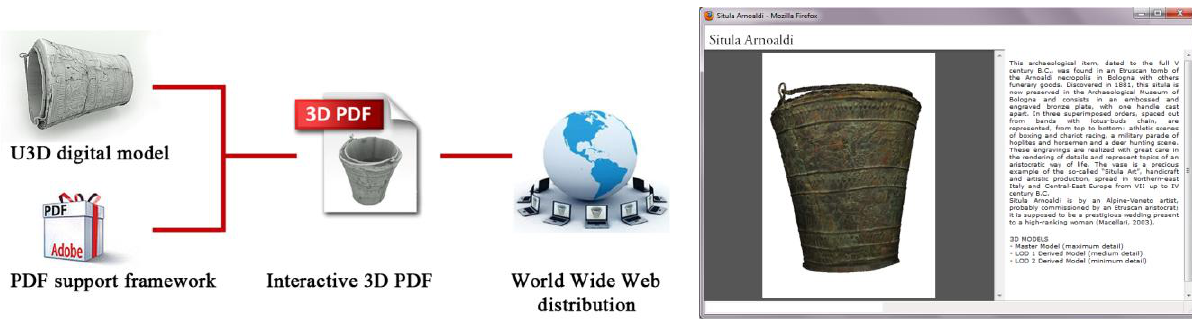
Figure 8. Left, schematic pipeline of 3D PDF document generation and distribution. Right, example of the visualization of the 3D PDF situla Arnoaldi model inside a browser window.